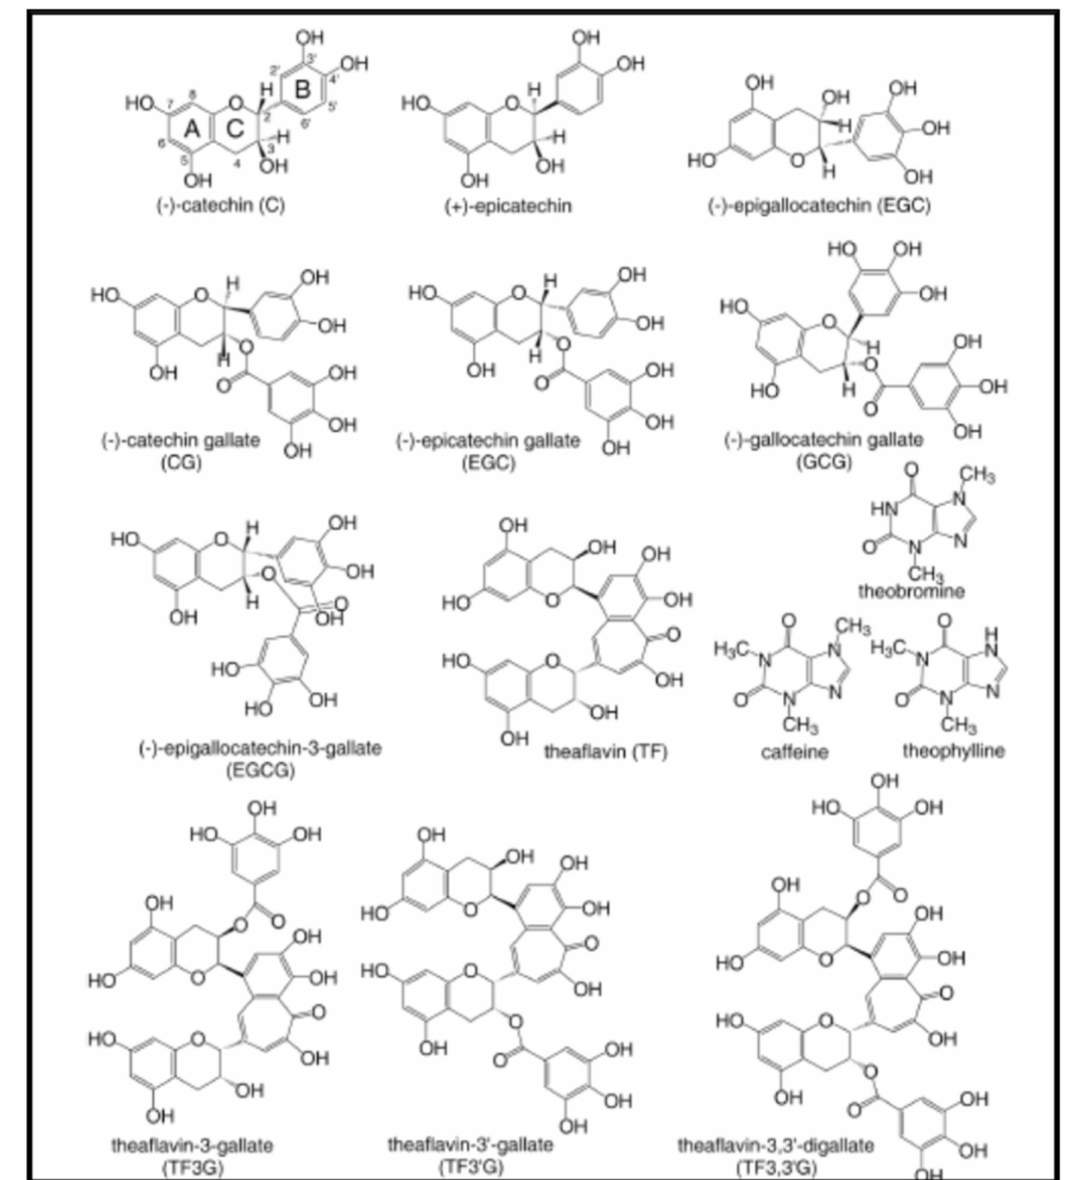
Figure 5. Structure of tea